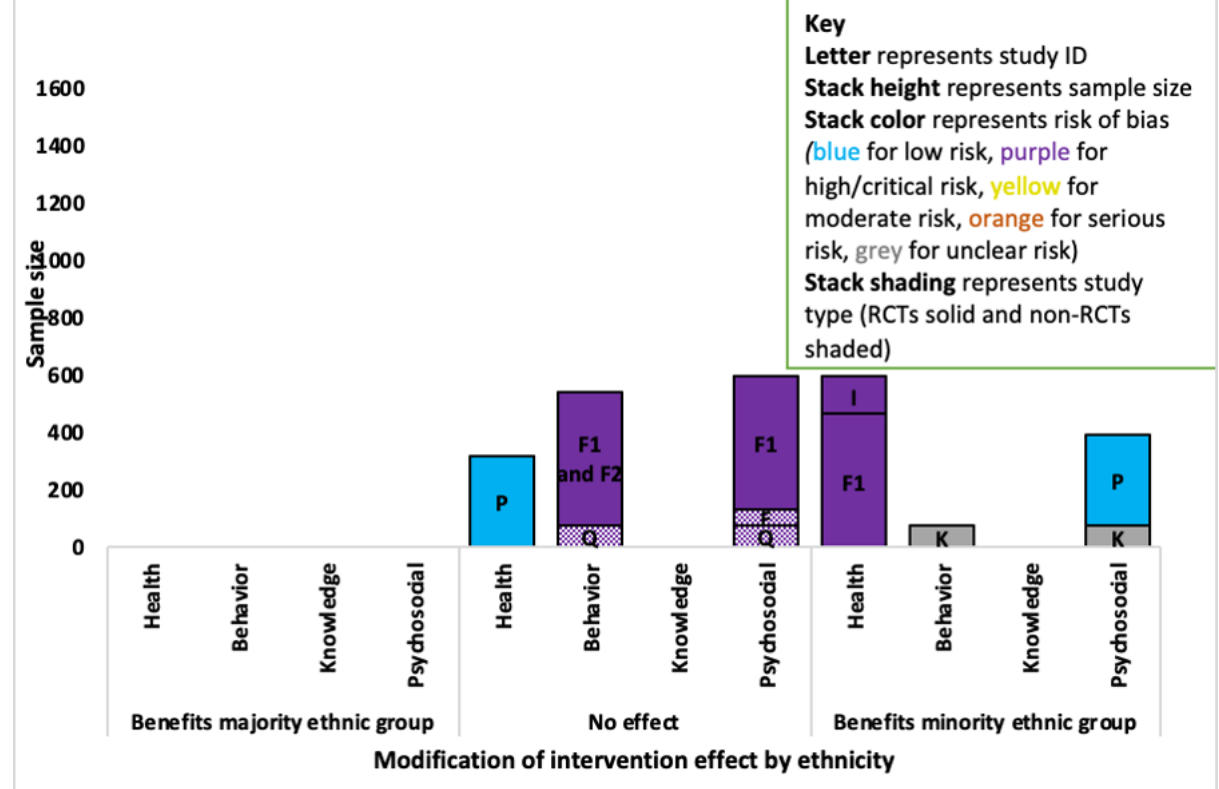
Figure 8. Adapted Harvest plot for minority ethnic group modifying intervention effects across outcomes in diabetes studies. RCT: randomized controlled